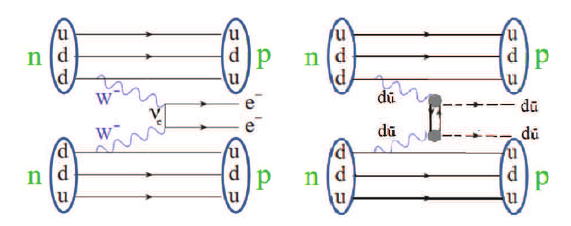
Figure 1. The elementary weak interaction process mediating nuclear 0 ν 2 β decay (left) and a corresponding strong interaction process (right) are depicted schematically. The QCD counterpart is given by the simultaneous emission of two [ d ¯ u ] pairs in an isovector-vector, e.g. 1 − , configuration (wavy lines), decaying into a pionic [ d ¯ u ] configuration and a charge-neutral q ¯ q